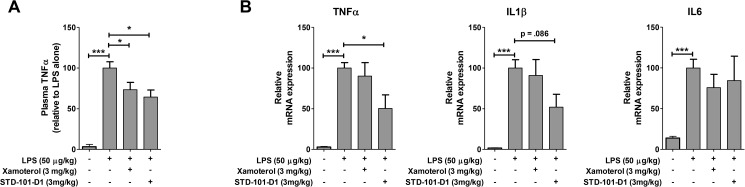
Inhibitory effects of ADRB1 ligands on LPS-induced TNFα response in mice.(A) Plasma TNFα concentrations in control animals and animals pretreated with xamoterol or STD-101-D1 90 min after LPS injection. (B) TNFα, IL1β, and IL6 mRNA expression in homogenized cortical tissue from control mice and animals pretreated with xamoterol or STD-101-D1 90 min after LPS injection. Data are represented as mean ± S.E.M.s of three independent experiments. (n = 4–14 per group, * p < 0.05, **p < 0.01, *** p < 0.001, one-way ANOVA followed by Dunnett’s multiple comparison).